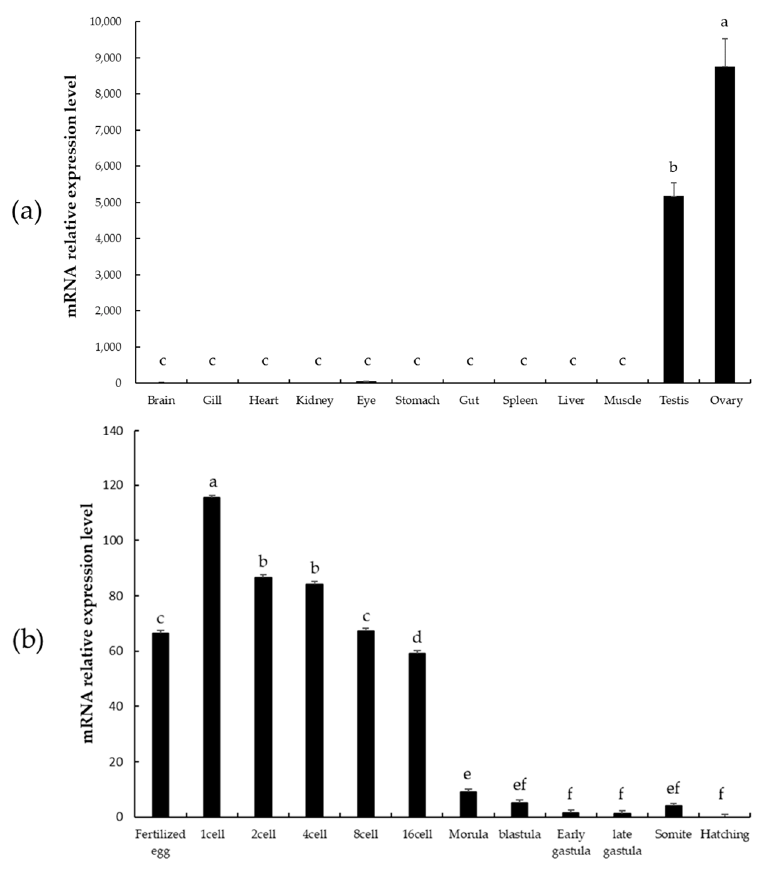
Figure 5. psdnd transcript expression levels in various tissues and embryo stages measured by qRT- PCR. ( a ) Tissue-specific expression of psdnd ( p < 0.05). ( b ) Embryonic expression of psdnd. Different letters indicate statistically significant difference ( p < 0.05).